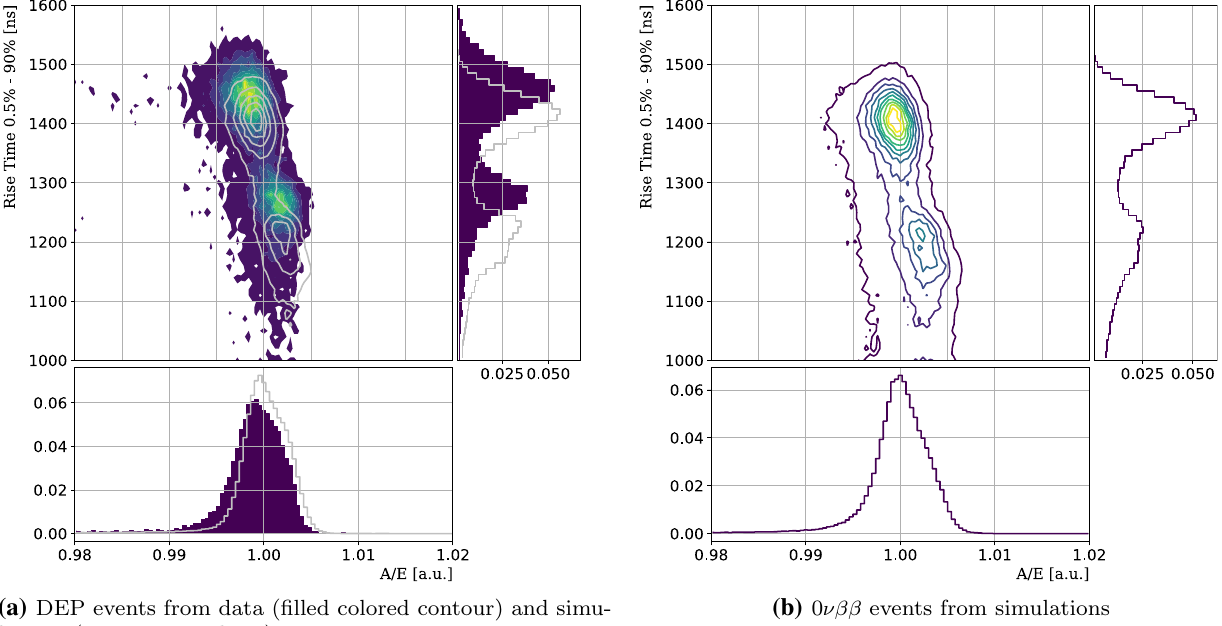
(b) 0 νββ events from simulations